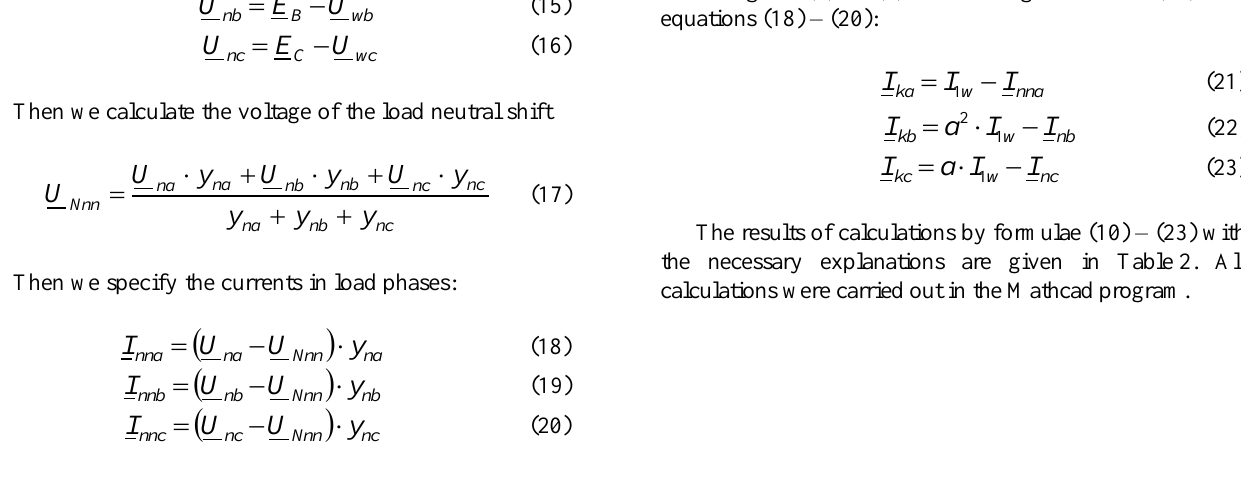
Table 2 – Сalculation of the balancing device currents by the diagram of Figure 2 according to formulae (10)–(23)